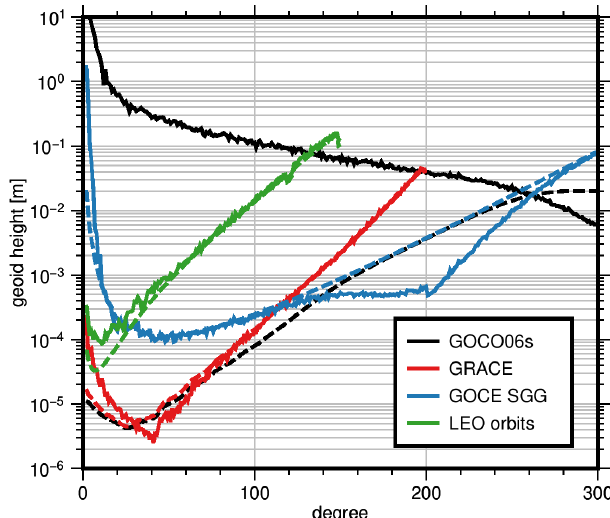
Figure 9. Difference degree amplitudes compared to GOCO06s (solid lines) and corresponding formal errors (dashed lines) of the individual GOCO06s components (polar cap with 8 ◦ aperture angle excluded). SLR is not shown because no stand-alone solution can be computed due to the ill-posed adjustment